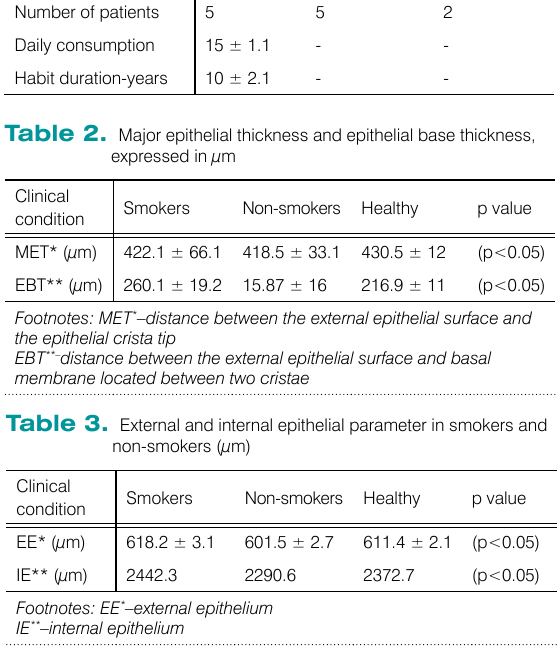
Figure 1 . Spinous stratum of gingival epithelium